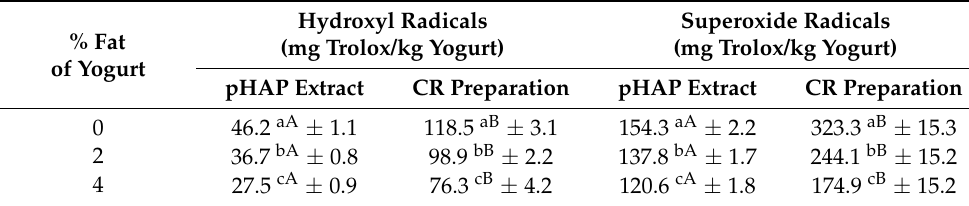
Table 9. Hydroxyl and superoxide anion radical scavenging activities of cow yogurts with different fat content preparations obtained by pH adjustment and precipitation (pHAP) and “Clarifying Reagent” (CR) 1